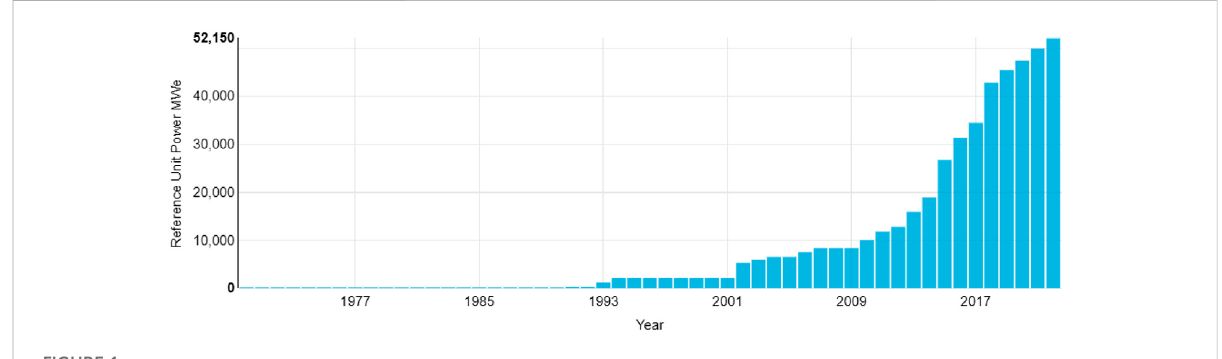
FIGURE 1 Nuclear energy consumption in China from 1998 to